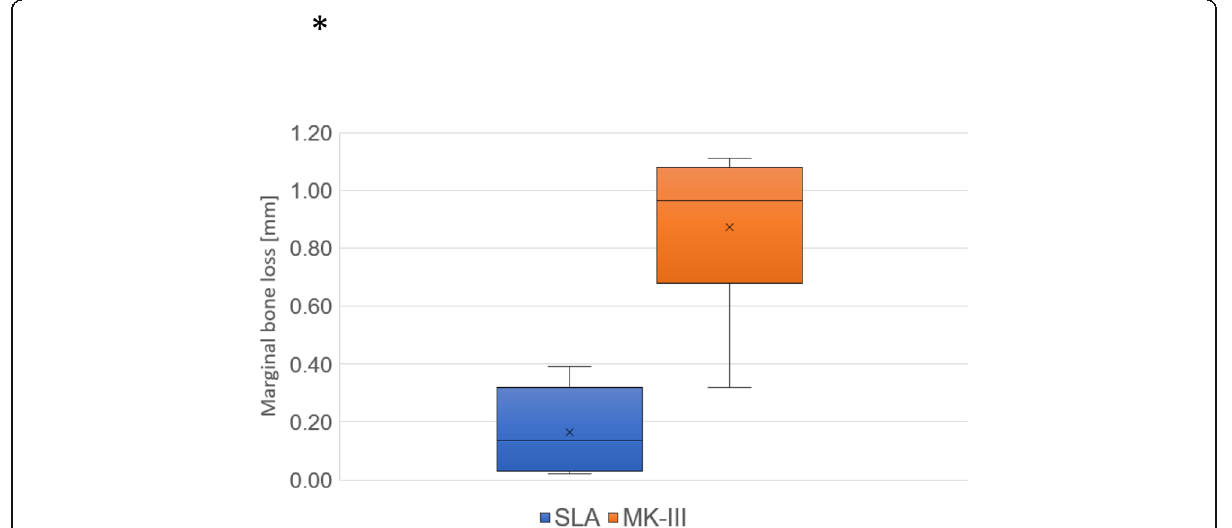
Fig. 6 Marginal bone loss (MBL) in SLA and MK-III implants within the abnormal group. MBL is significantly larger in MK-III implants than SLA implants during the follow-up period